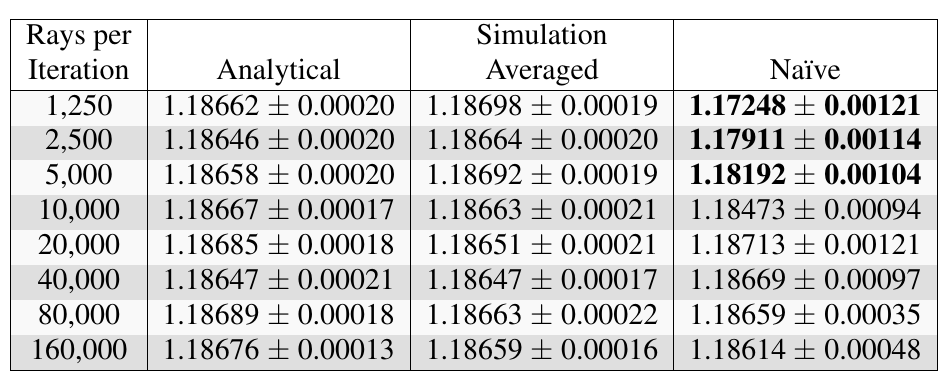
Table 1: Eigenvalue and standard deviations of different estimators. Bold indicates entries with error from the reference solution greater than 3 standard